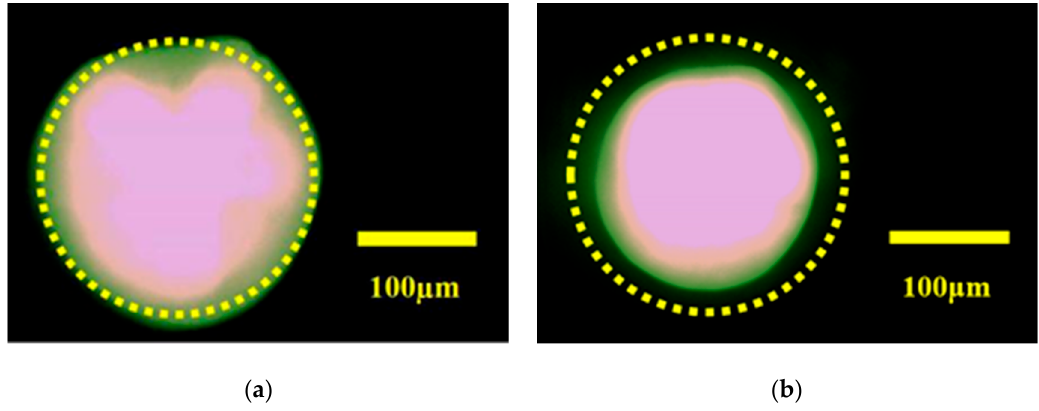
Figure 5. ( a ) Light spot under the state of voltage off. ( b ) Light spot under the state of voltage on. Based on the above experiments, the refractive indices of different concentrations of NaCl solution were measured according to the above experimental procedures. The measurement results are shown in Table 1.